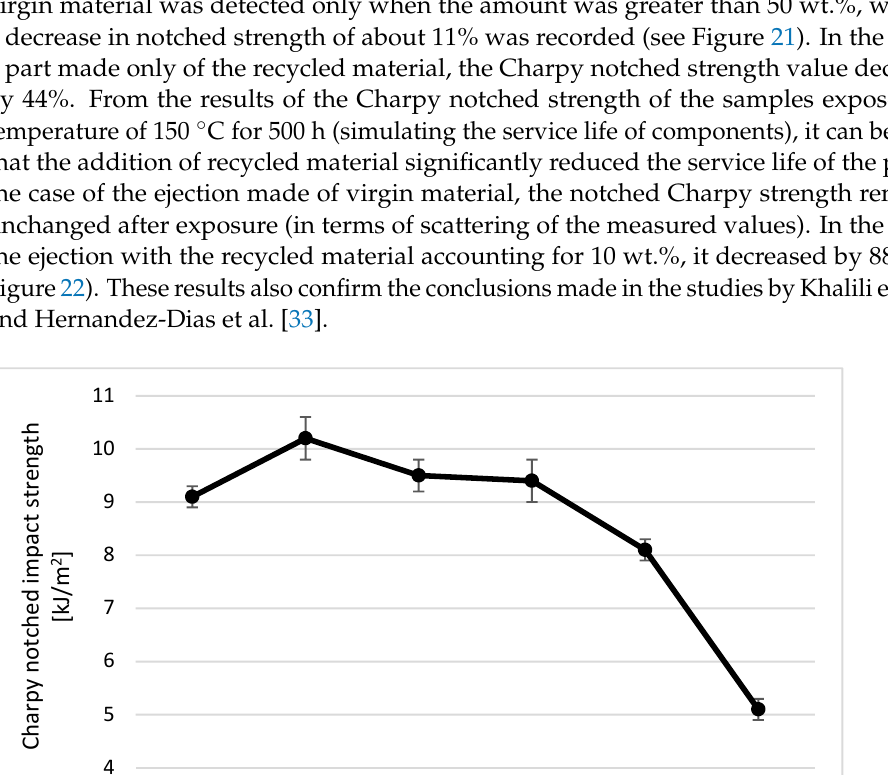
Figure 20. Dependence of the flexural strength on the amount of the recycled material after exposure of samples to elevated temperature.